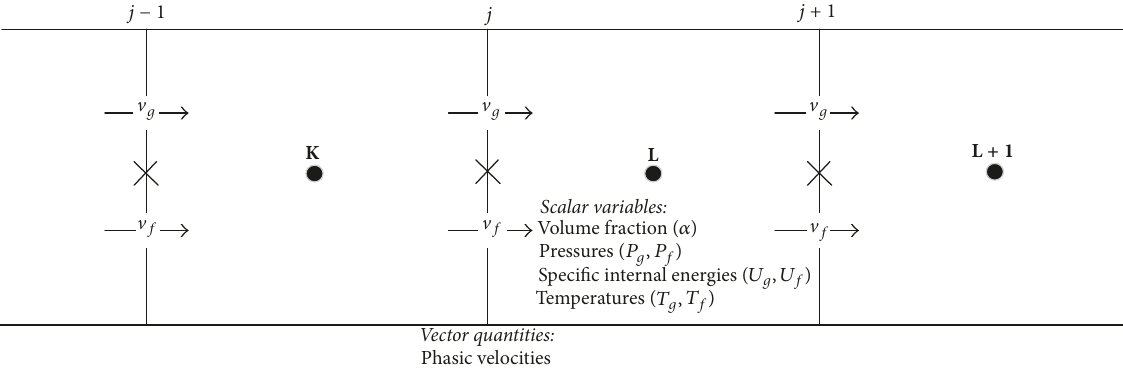
Figure 1: Schematic diagram of the staggered